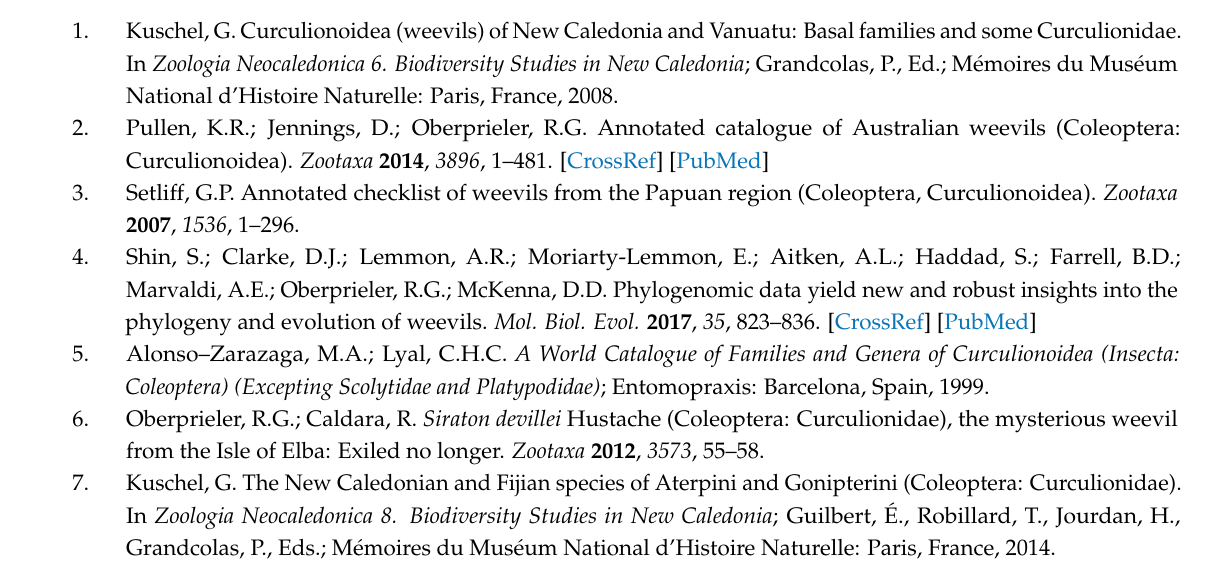
Figure 19. Imbilius araucariae : ( a ) head of male, dorsal aspect, ( b ) aedeagus, dorsal aspect.